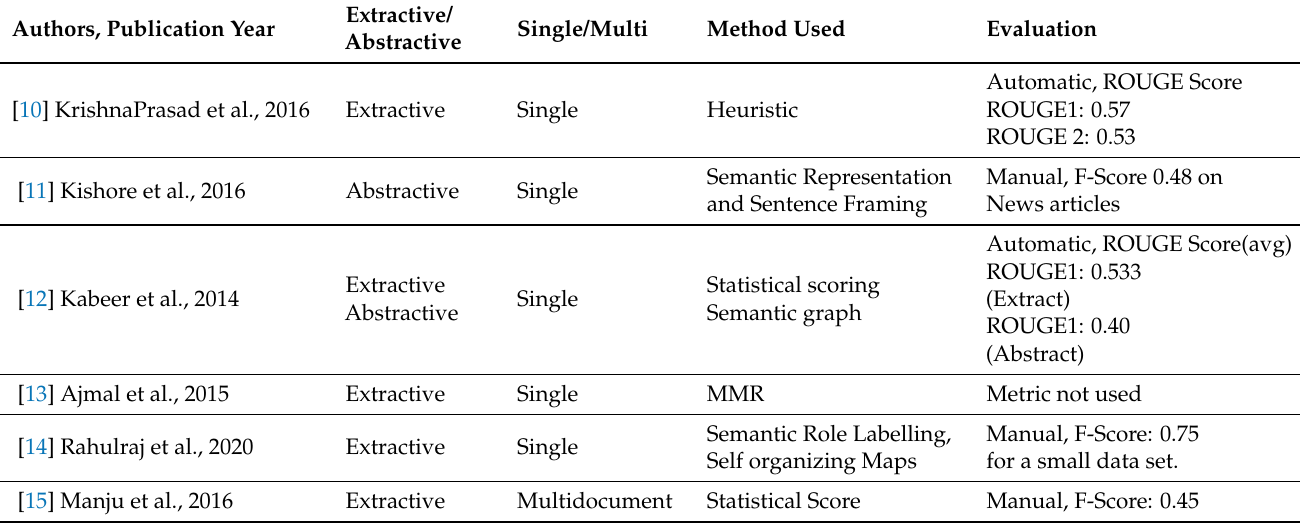
Table 1. Malayalam Text summarization studies in the